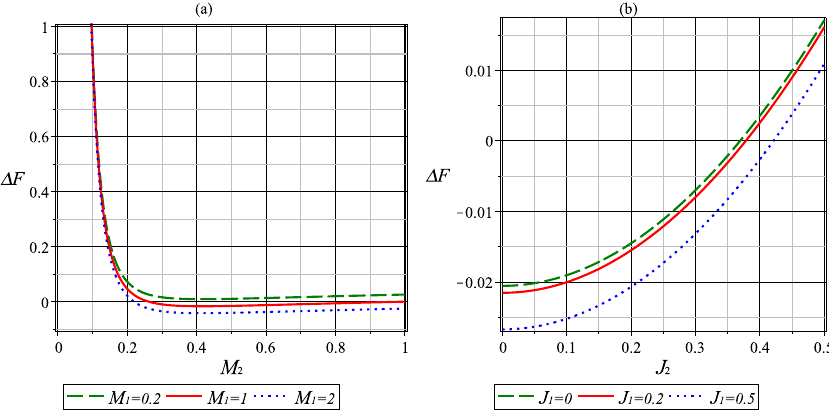
Figure 2 . ∆ F of the Myers-Perry black hole in terms of (a) final mass with η = 0 . 95 , J 1 = 0 . 1 , and J 2 = 0 . 2 ; (b) final angular momentum with η = 0 . 95 , M 1 = 0 . 5 , and M 2 = 1